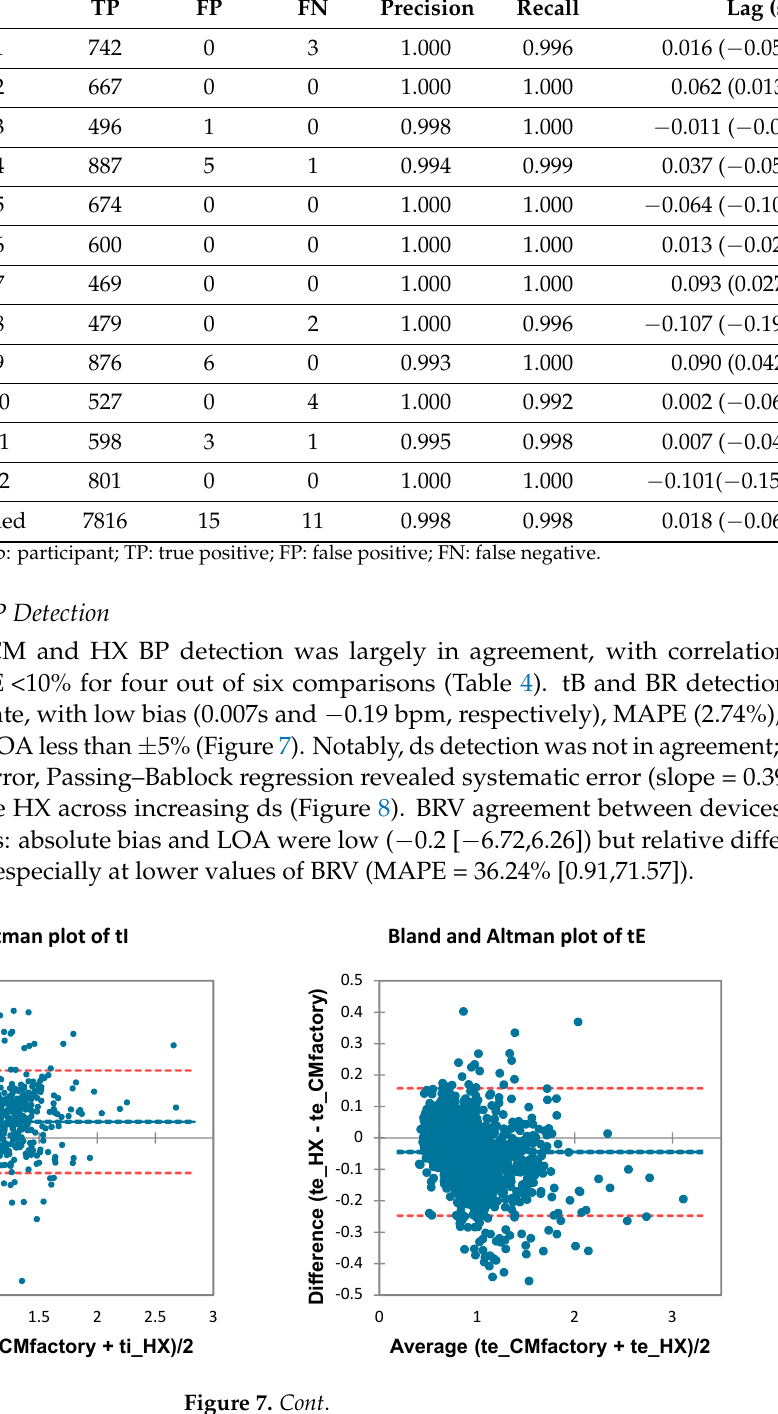
Table 3. FR detection